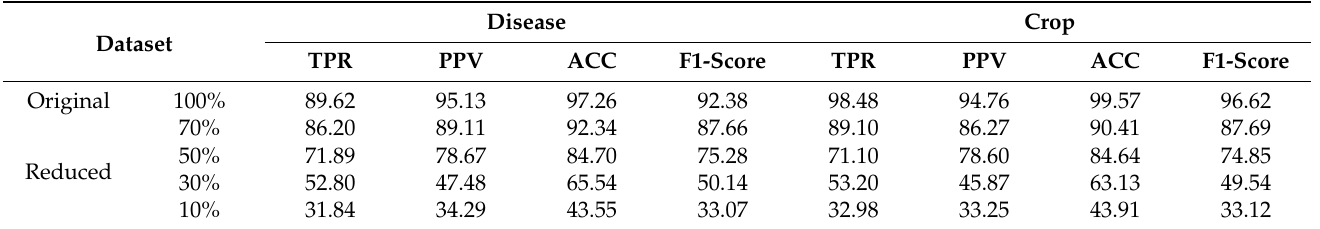
Table 16. Comparison of accuracies achieved by the proposed PI-CNN in the original and reduced datasets. The accuracies were achieved in the PlantVillage dataset (unit: %). Disease Dataset